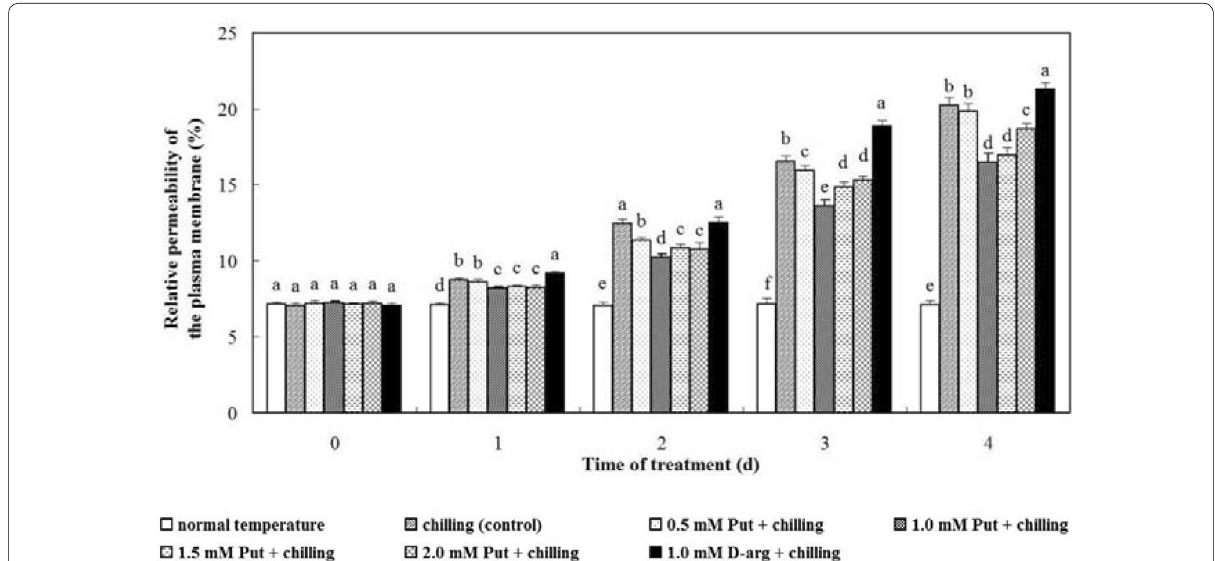
Fig. 1 Effects of exogenous Put and d -arg on the relative permeability of the plasma membrane in the leaves of anthurium seedlings under chilling stress. Seedlings were treated with normal temperature, chilling (control), 0.5 mM Put Put chilling or 1.0 mM d -arg chilling for 3 days and a recovery for 1 day, and the relative permeability of the plasma membrane in the leaves was + + assayed. Each point represents the mean SE (n 5). Treatments marked with different letters at a given sampling date are significantly different at ± = P <